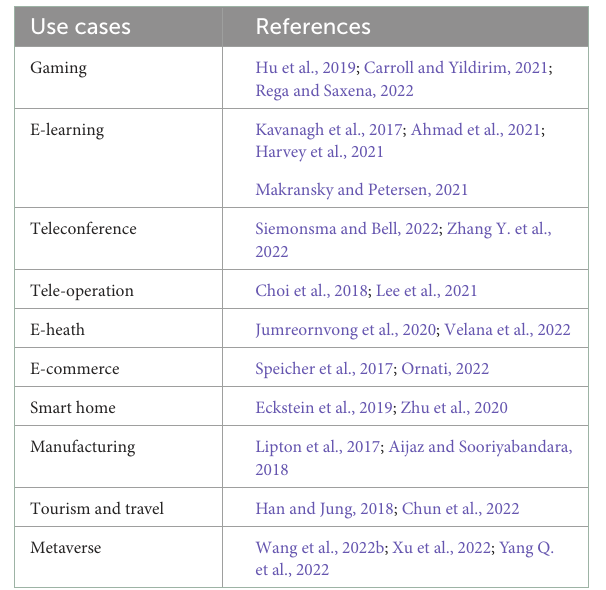
FIGURE1 Main forms and exemplary use cases of immersive